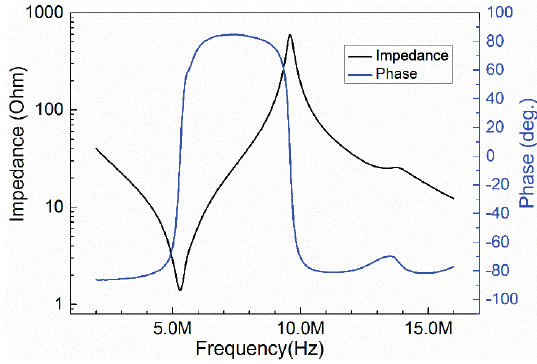
Figure 1. ( a ) Photograph of the prepared PMNT/epoxy 1–3 composites; ( b ) Enlarged image of a randomly selected area on the composite.